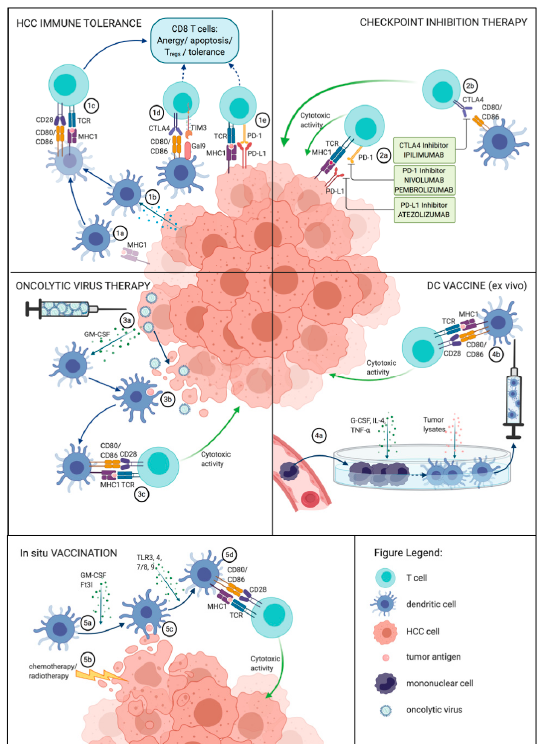
Figure 1. Dendritic cell (DC)–T cell-tumor interactions as targets of hepatocellular carcinoma (HCC) immunotherapy . HCC tumors employ various strategies of immune evasion. One of them is